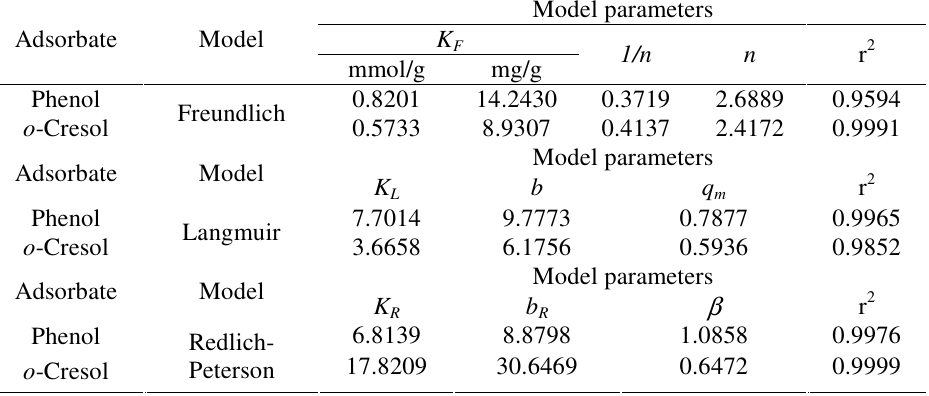
Table 1 . Isotherm parameters for the adsorption of phenols on CC at 30 °